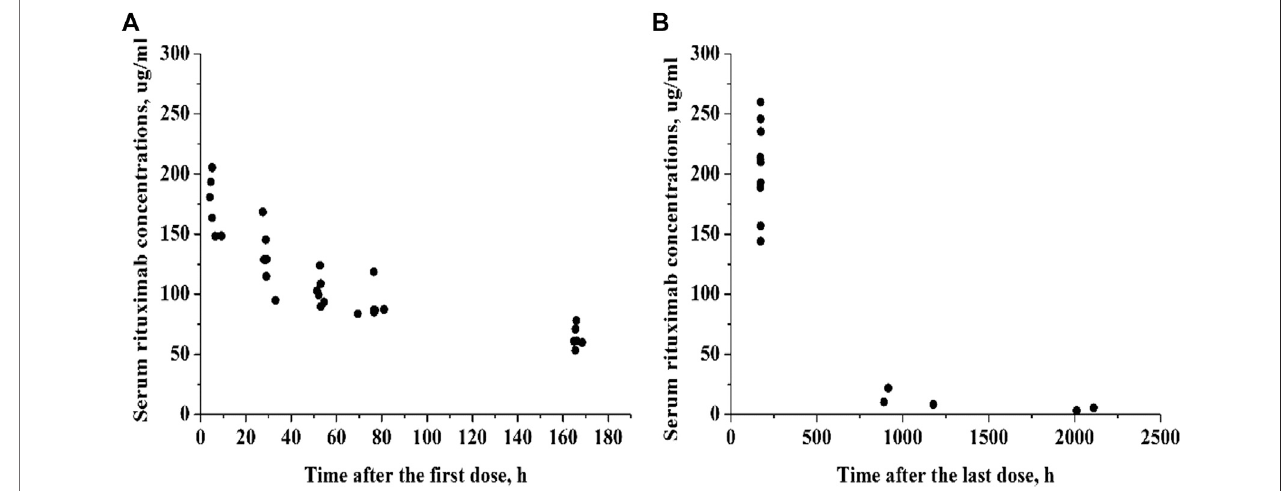
FIGURE 1 | Individual serum rituximab concentration-time pro fi les. (A) Concentration plots after the fi rst dose. (B) Concentration plots after the last dose.